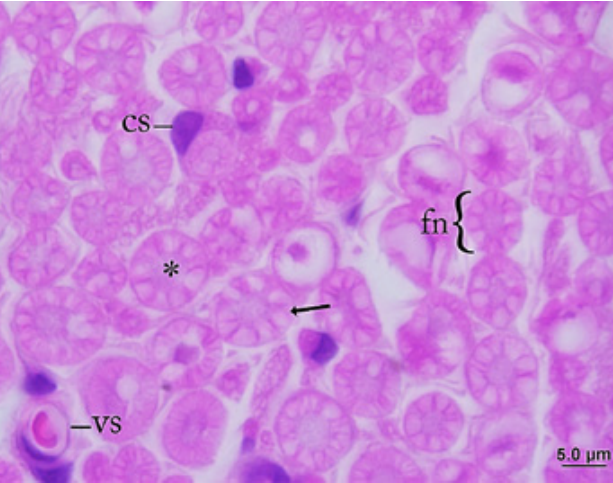
Figure 1. Photomicrography of the sciatic nerve, with a 100x objective, cross-sectional and stained with hematoxylin and eosin. The tip of the arrow indicates the myelin sheath; the asterisk is on the axon; vs - blood vessel; fn - myelin nerve fiber; and cs - Schwann cell. The cut presents some artifacts of histological technique on the myelin sheath of some nerve fibers. Morphometry of the Sciatic